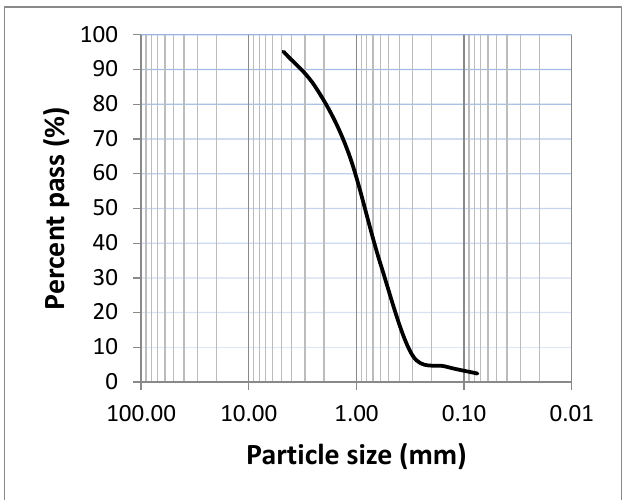
Figure 1. Particle size distribution of the used sand [23].